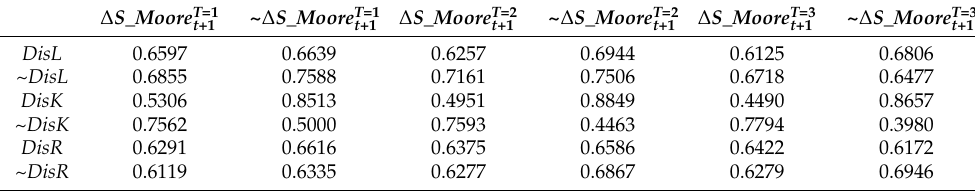
Table 3. Necessity Analysis Table (Degree Value of Industrial Structure Change).